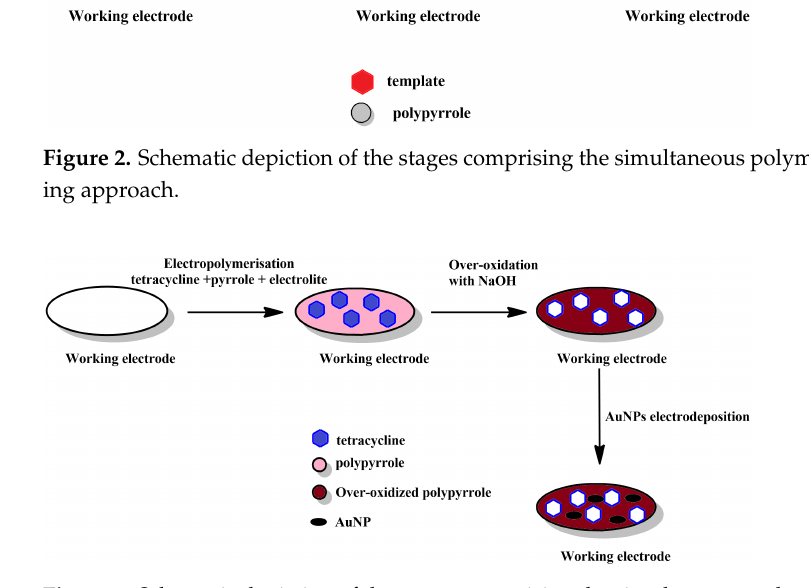
Figure 3. Schematic depiction of the stages comprising the simultaneous polymerisation and imprint- ing approach with over-oxidative